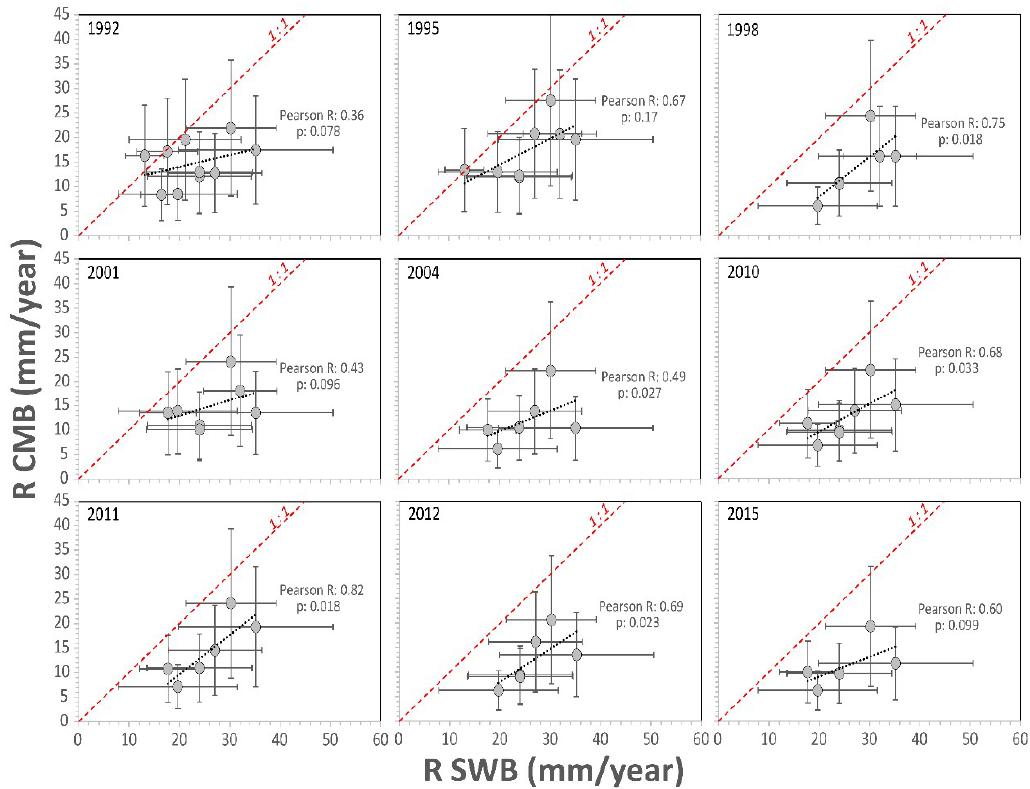
Figure 5. Comparison of soil water balance (SWB) vs. chloride mass balance (CMB) recharge estimates. Regression coefficients are shown with a 90% confidence interval. Horizontal error bars indicate one standard deviation from the mean of all SWB values within a 500 m well buffer. Vertical error bars represent range of measured Cl P values (see text for explanation).